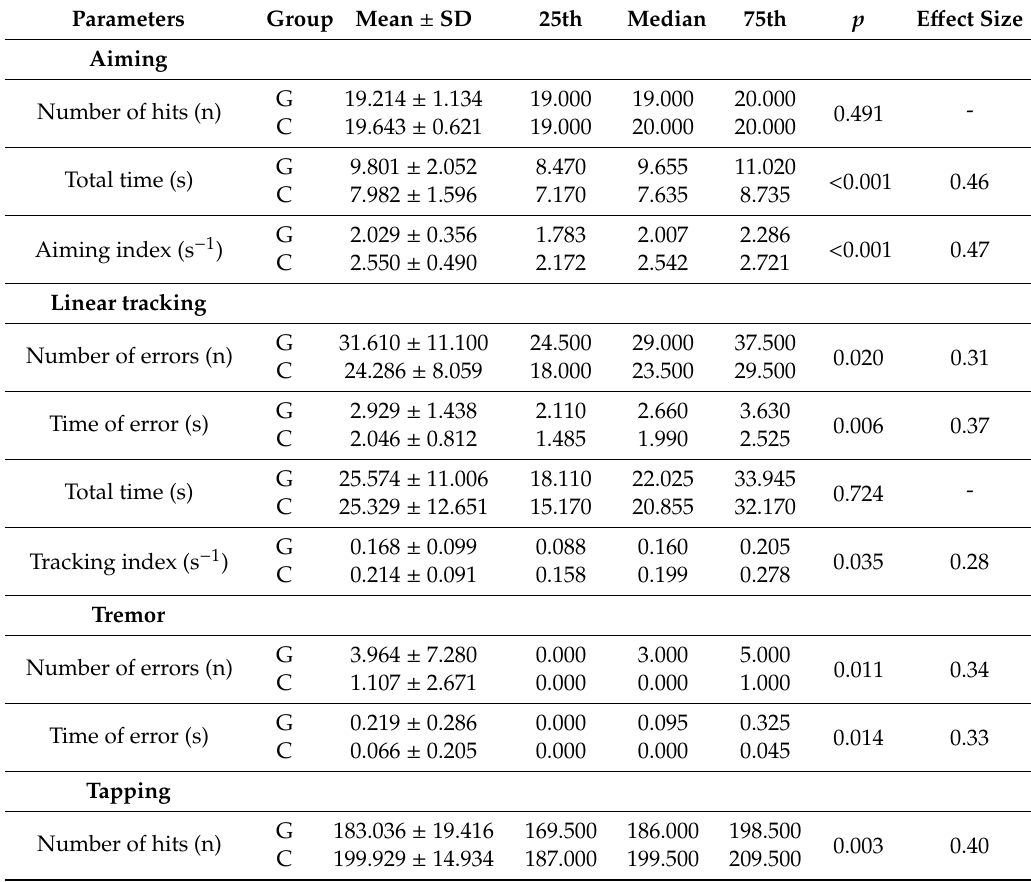
Table 2. Mean, standard deviation (SD), median, and 25th and 75th percentile for each eye–hand coordination parameter in glaucoma patients (G) and control subjects (C), and intergroup comparisons using the Mann–Whitney